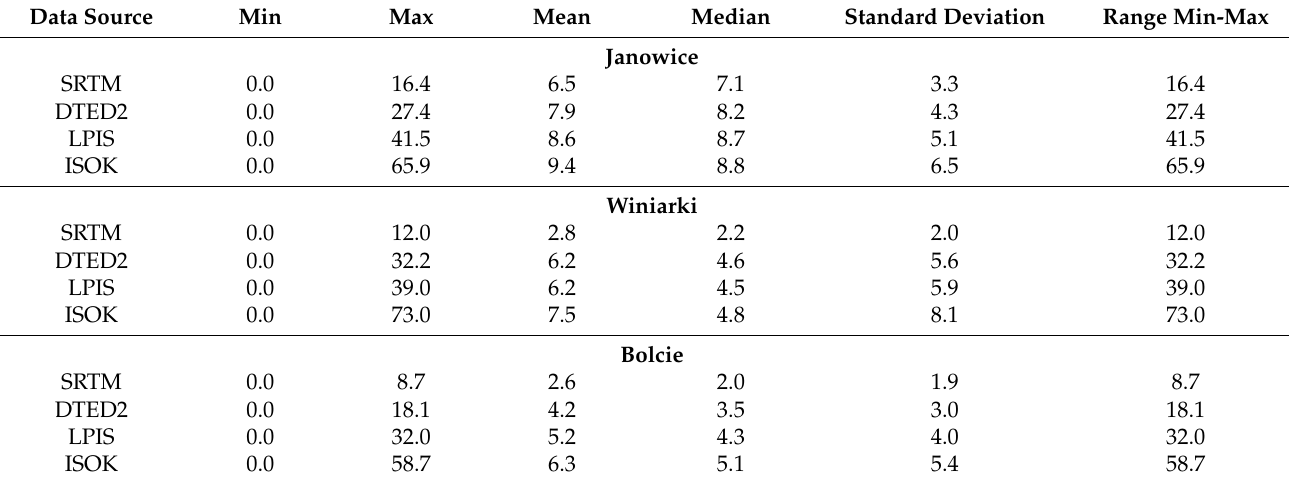
Table 6. Summary of the basic statistics of the slope values ( ◦ ) in the 3 research areas. Data